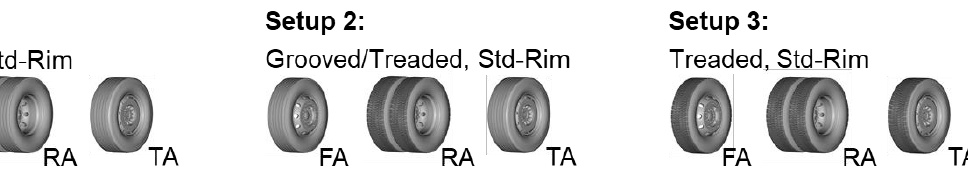
Figure 12. Overview of predefined wheel setups on the HDV depending on the tire type.